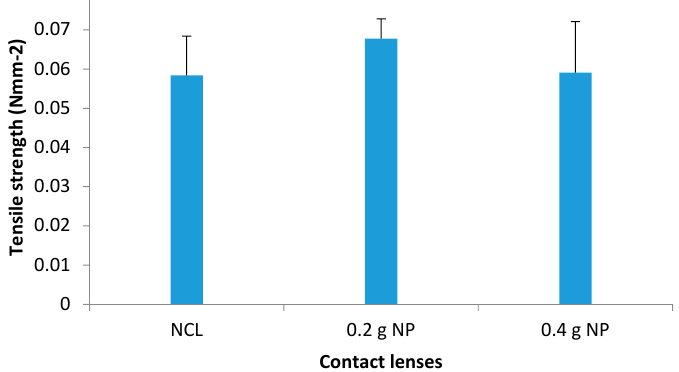
Figure 11. Tensile strength (Nmm − 2 ) of NCL, 0.2 and 0.4 g prednisolone NP-loaded contact lenses (mean ± standard deviation, n = 3).